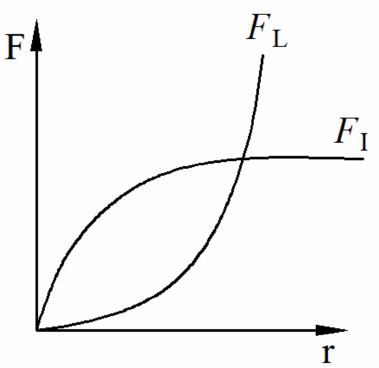
Figure 5. Trend chart of the differential pressure lift and impact resistance with